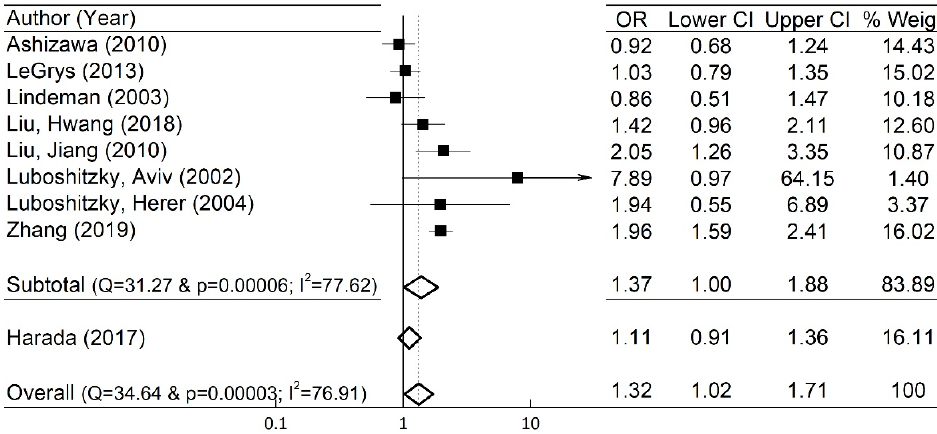
Figure 4. Sensitivity analysis via exclusion of the study of Harada (2017). Forest plot in a group ( n = 8) without the study of Harada (2017). % weights are from the random-effects model in the whole studies ( n = 9). OR for each included individual study is denoted by a solid square ( ), while its CI is represented by a horizontal line. The centers and the widths of the diamonds ( ) represent the ORs and the CIs for the excluded study of Harada (2017) and the pooled ORs and CIs in the subtotal and the overall cases, respectively.